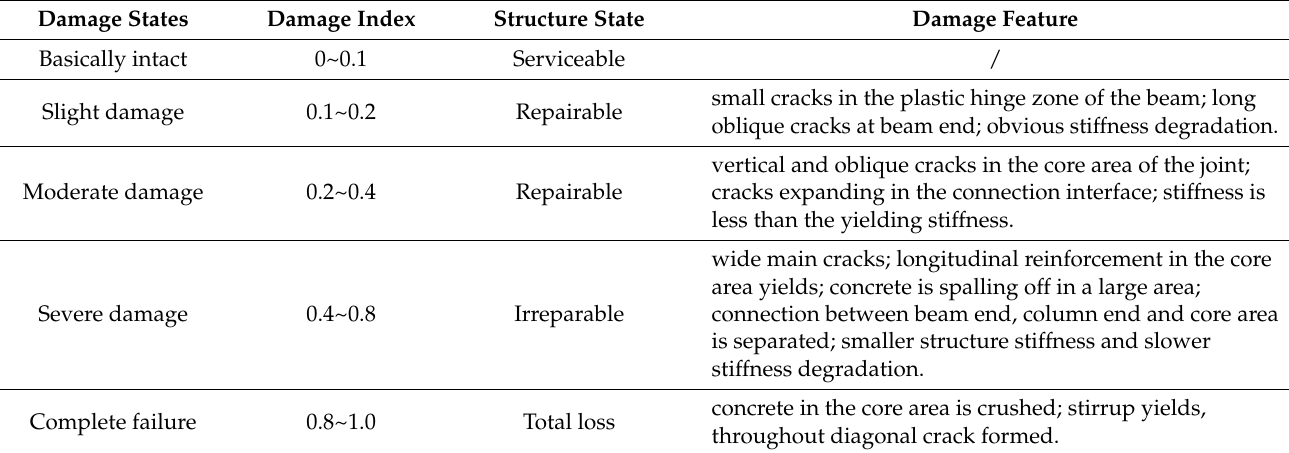
Table 5. Damage states of the monolithic precast beam-column